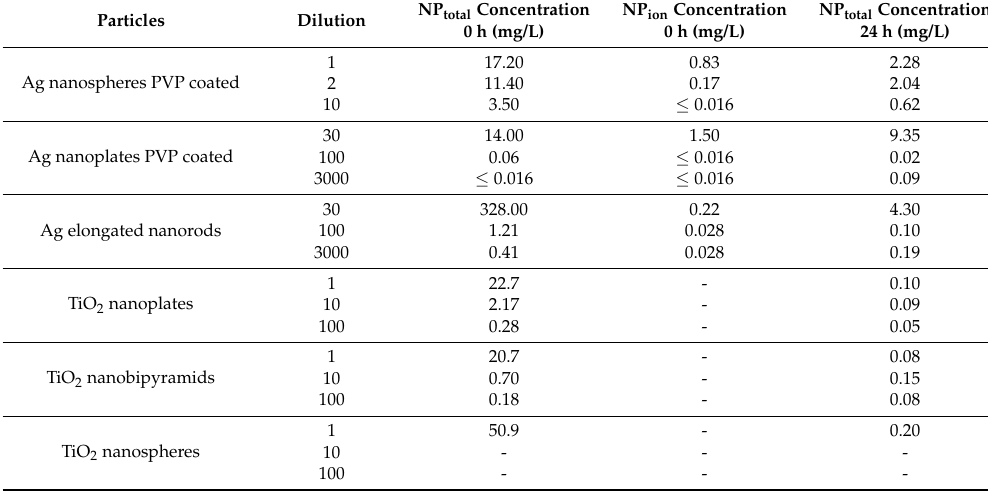
Table 1. Actual concentrations of Ag NPs and TiO 2 NPs in suspension at 0 and 24 h. For each dilution step, total concentration (NP total ), dissolved ion concentration (NP ion ) at 0 h, and total concentration (NP total ) at 24 h are displayed for each NP